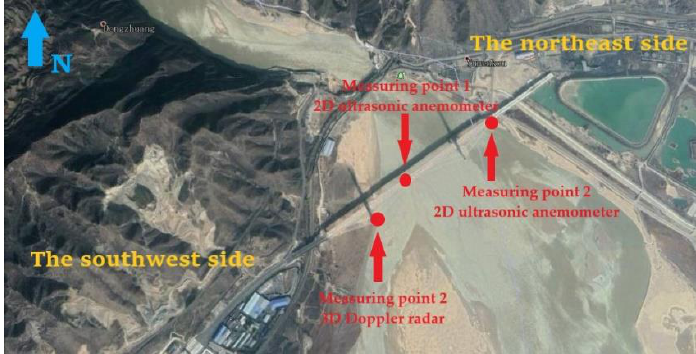
Figure 1. Local topography at the bridge site and the layout of the measuring points.